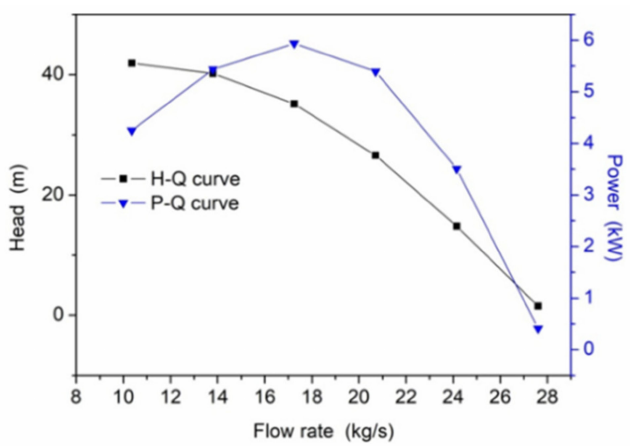
Figure 11. Pump hydraulic performance in terms of head and power.